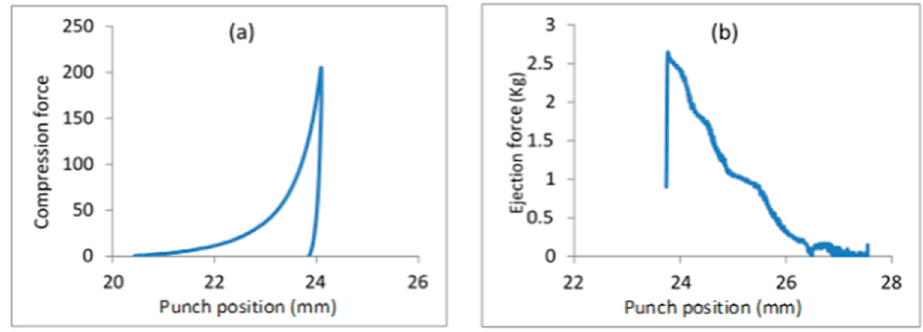
Figure 9. Force-displacement profiles during ( a ) the compression and ( b ) ejection stages of tableting SEPs with Avicel 101 at 70:30 ratio.